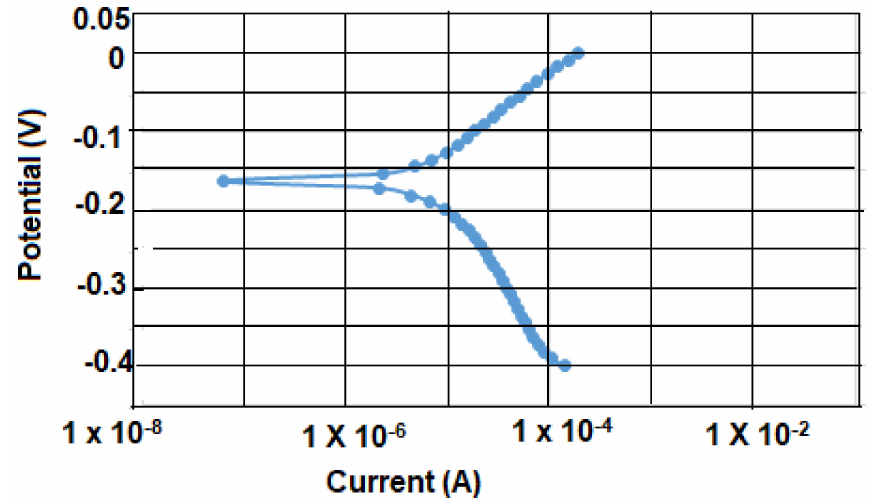
Figure 7. Potentiodynamic curve of the Cu-Zn GQD